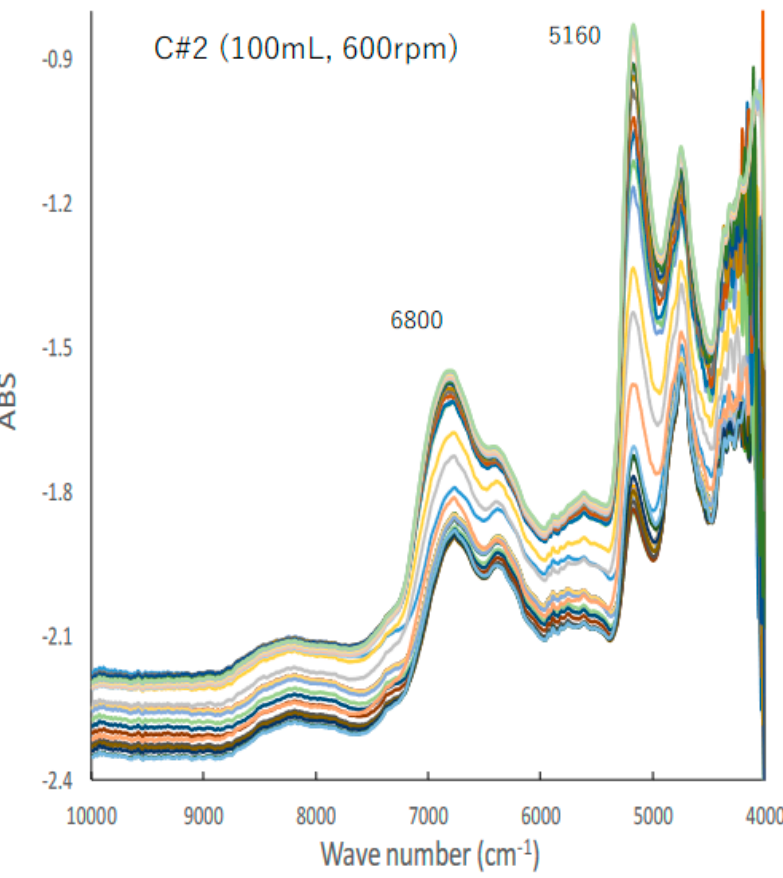
Figure 2. A typical change in the NIR spectra of the C#2 formulation during HSWG process.